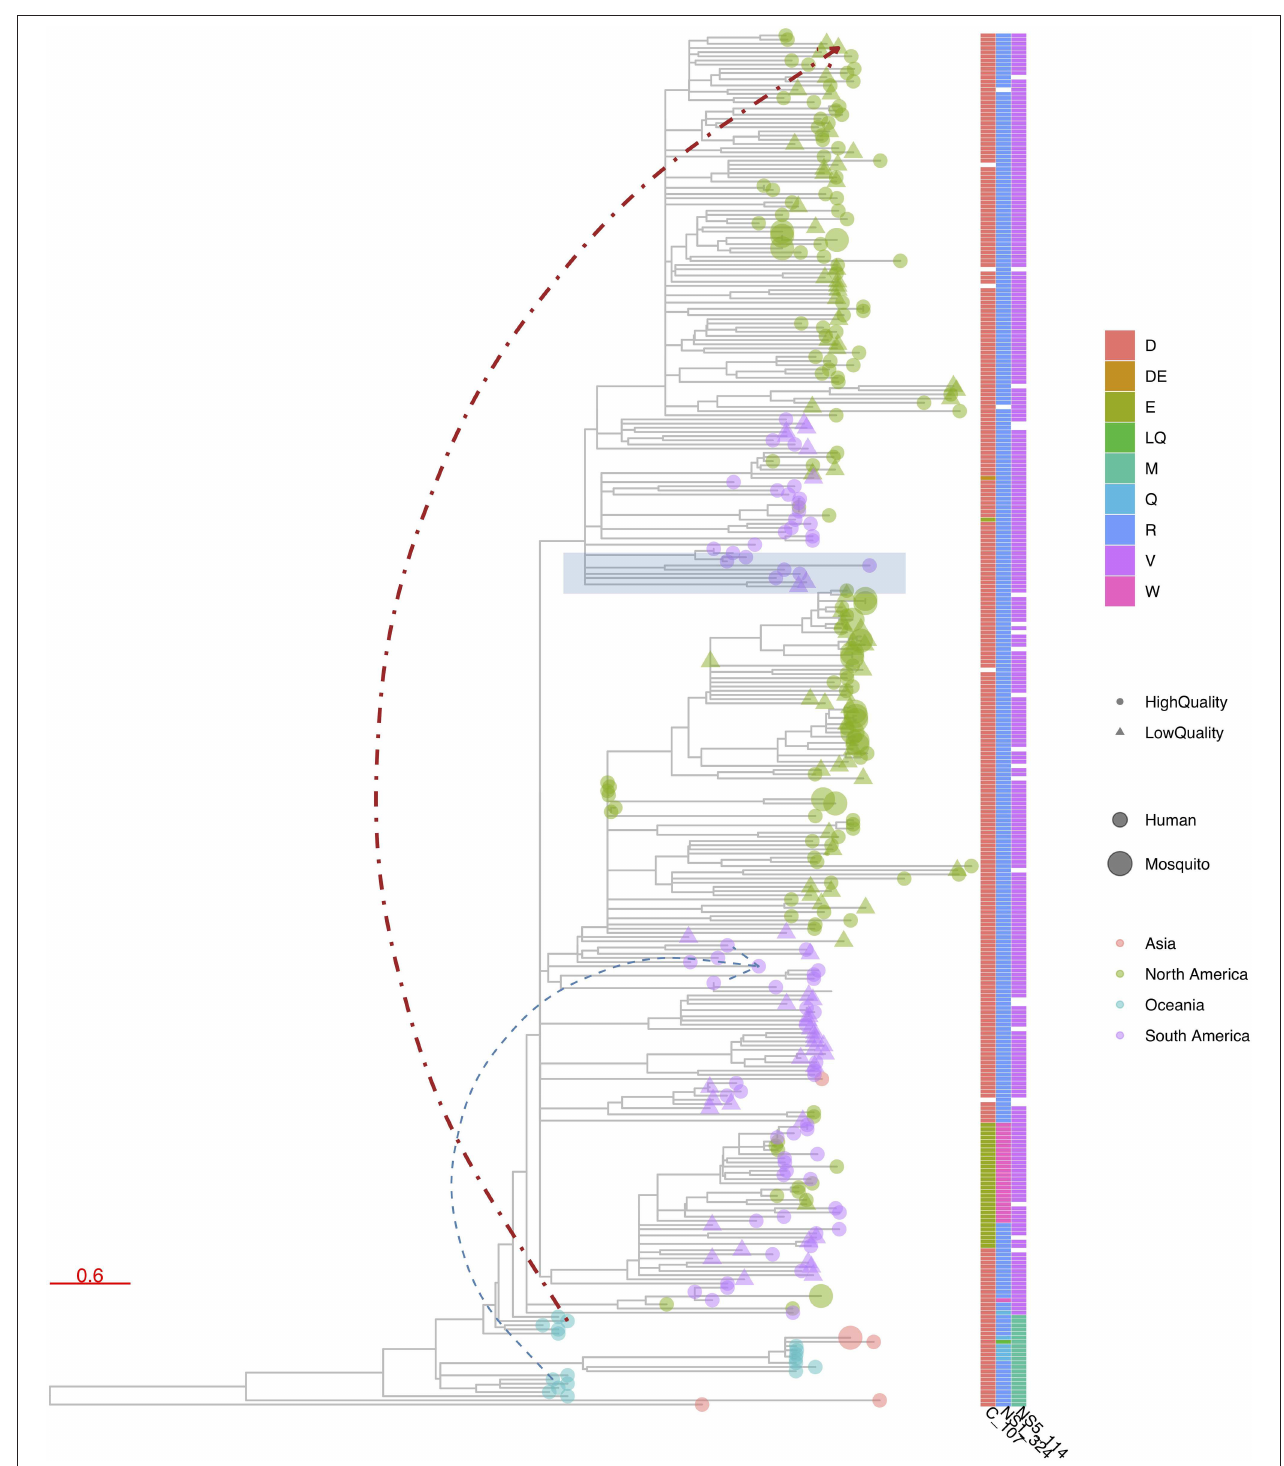
FIGURE 6 | R package ggtree (48) visualization of a phylogenetic tree constructed from publicly available Zika virus (ZIKV) genomes. ggtree allows similar advanced customized visualization of phylogenetic trees as e.g., iTOL, but by means of the traditional R scripting language. In this figure, tree leaves are colored according to continent of sampling, with a size corresponding to the host status and shape indicating the completeness of the CDS, using a cutoff of 99% of nucleotide positions being informative. A heatmap was added to denote the presence of amino acid mutations at three chosen genome positions. Finally, a particular clade was highlighted in blue based on a given internal node and two additional links between chosen taxa were